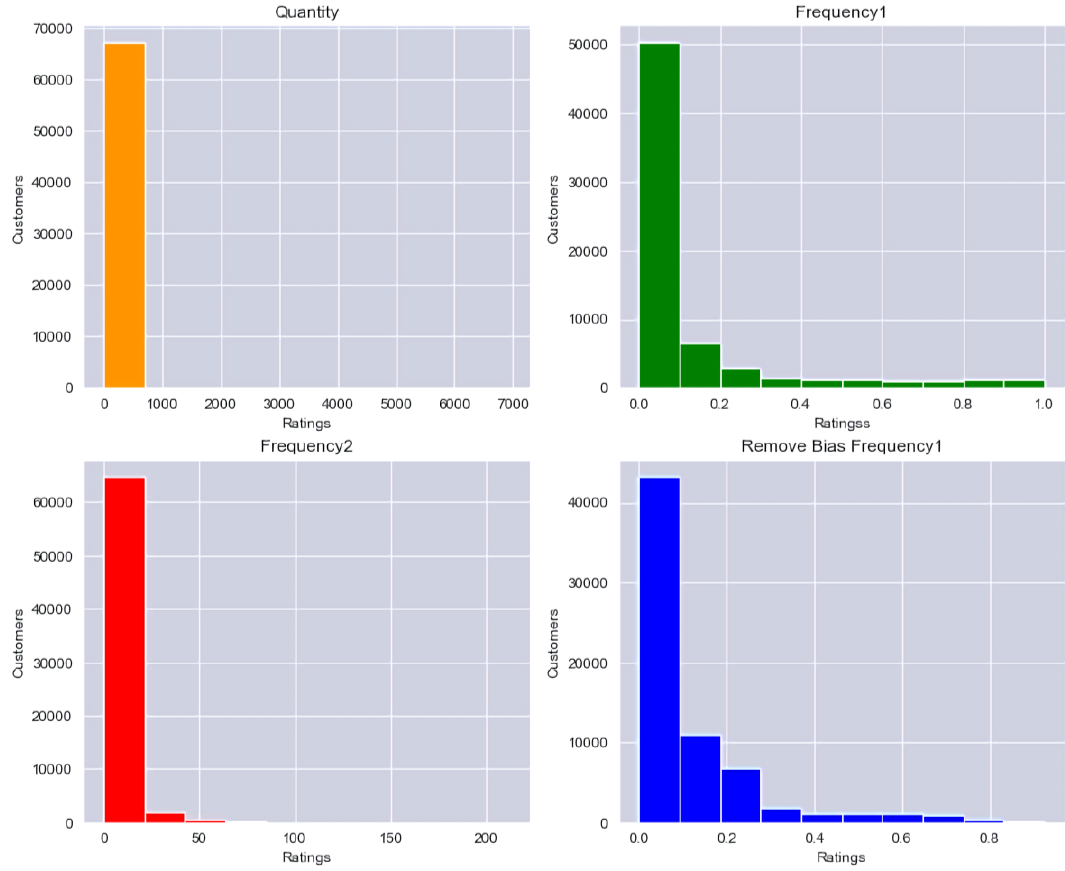
Figure 4. Rating metrics’